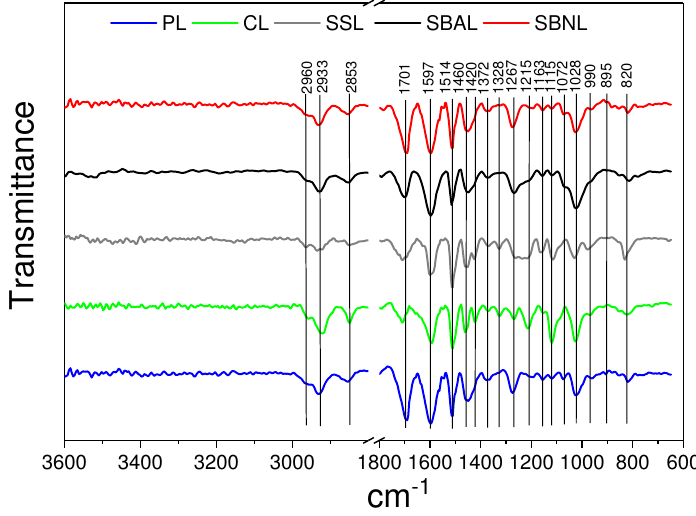
Figure 1. Experimental IR spectra of lignin samples. The abbreviations of lignin fractionated from pine sawdust (PL), cotton stalks (CL), sweet sorghum bagasse (SSL), spruce bark with (SBAL) and without acid addition (SBNL) were